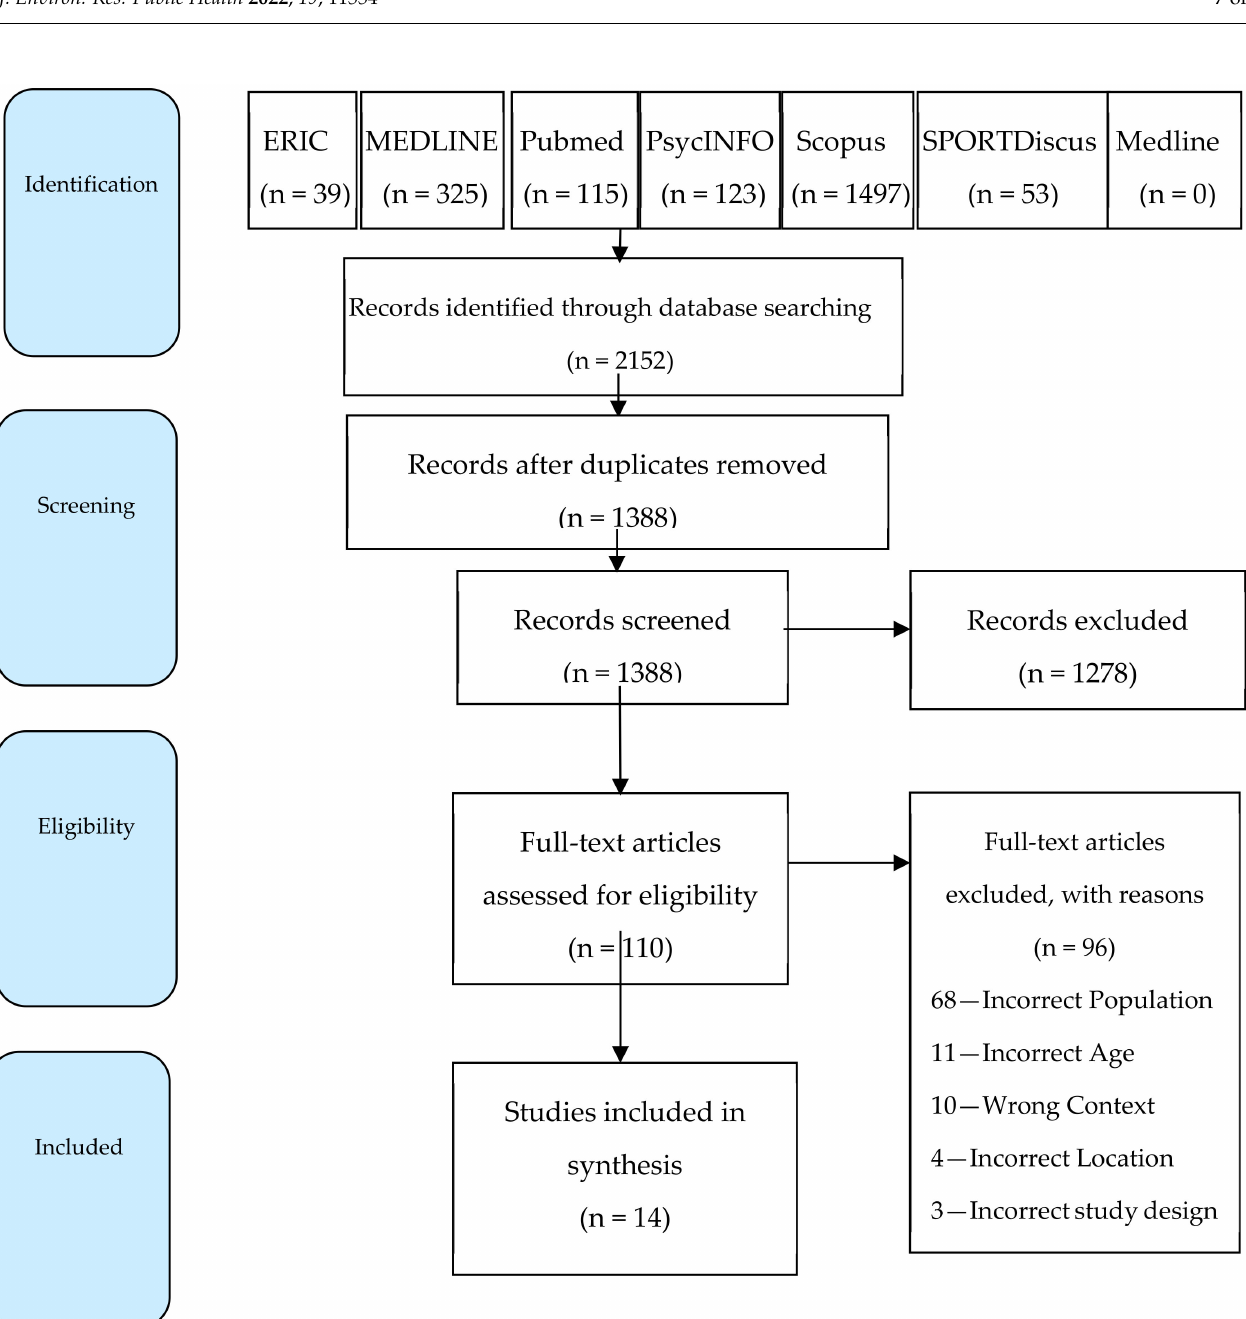
Figure 2. PRISMA flow diagram for study